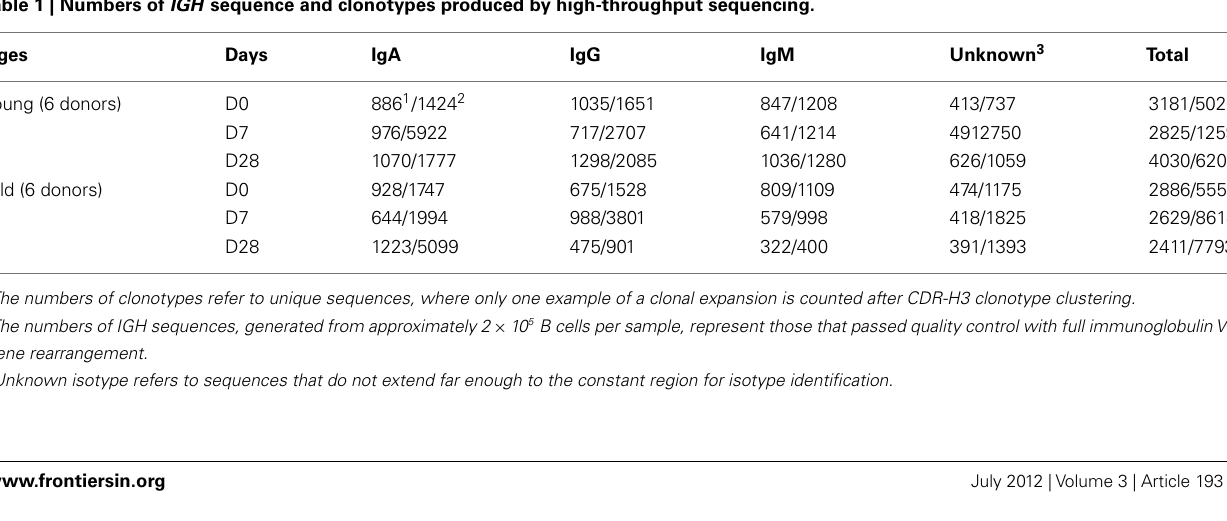
Table 1 | Numbers of IGH sequence and clonotypes produced by high-throughput